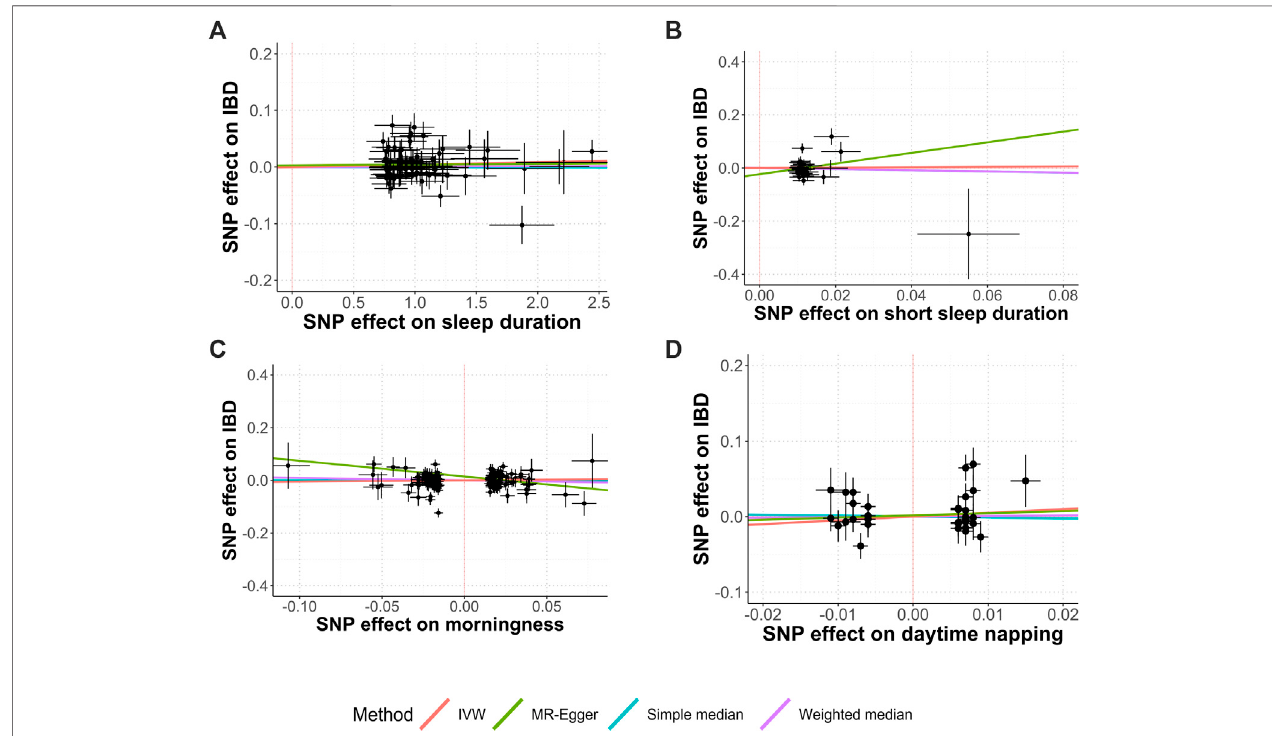
FIGURE2| Causalrelationshipsbetweensleepduration,morningness,daytimenapping,andIBD.Abbreviations:IVW,inverse-varianceweighted.MR,Mendelian randomization. SNP, single-nucleotide polymorphisms. Annotation: Scatter plots of the IBD-SNP associations (y-axis) versus the sleep-traits-SNP associations (x-axis) wereshowed,withhorizontalandverticallinesshowing95%con fi denceintervalsforeachassociation. (A) Sleepduration; (B) Shortsleepduration; (C) Morningness; (D) Daytime napping.